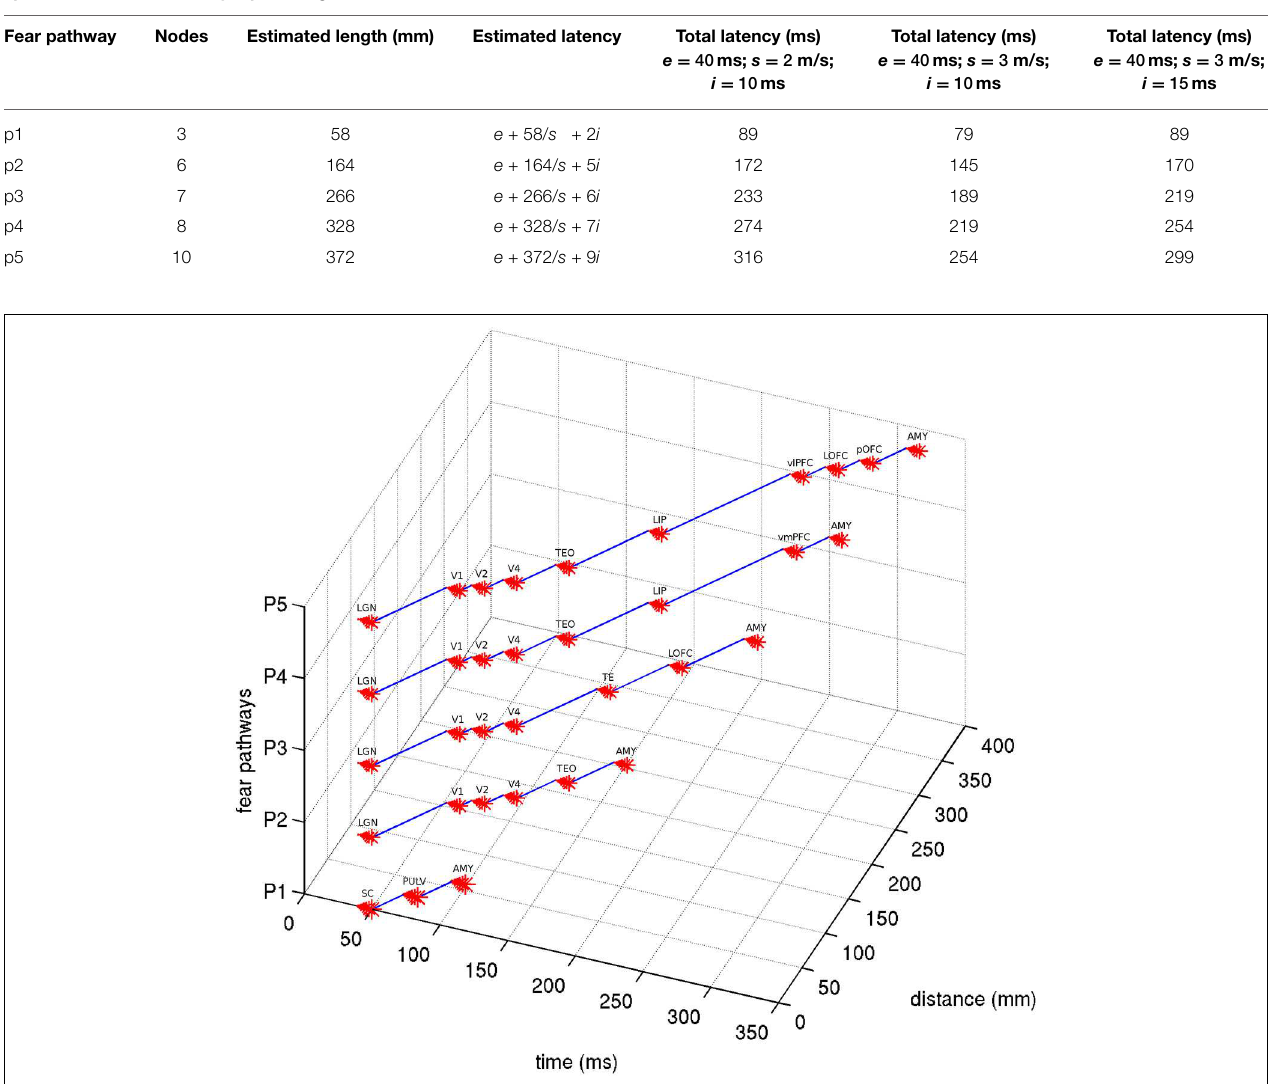
TABLE 5 | Predicted pathway latencies for arrival at the amygdala, where e is the latency between the retina and LGN/SC, s is the neural propagation speed in m/s and i is the synaptic integration time at each ROI node. Fear pathway Nodes